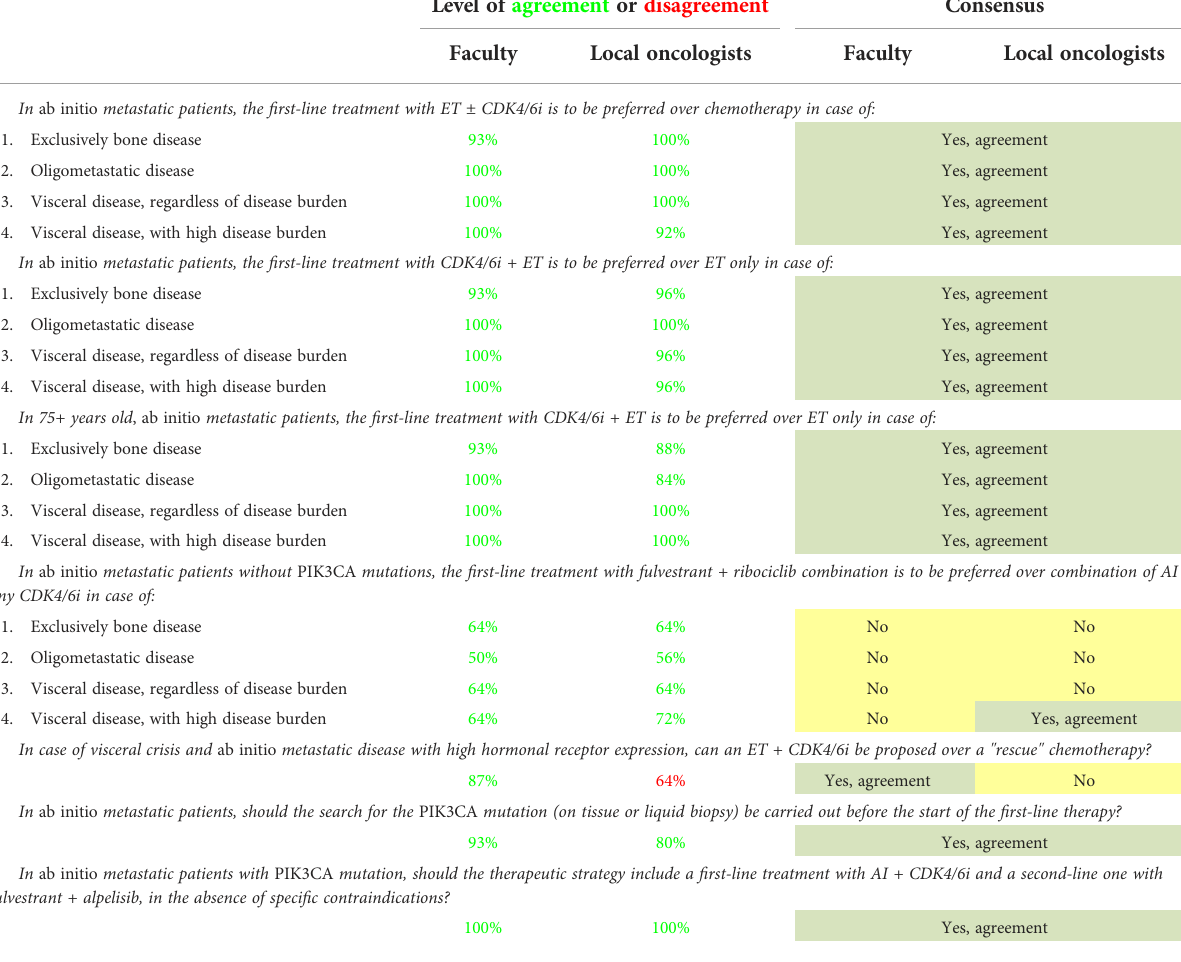
TABLE 3 Level of agreement and disagreement and consensus status on statements regarding ab initio metastatic